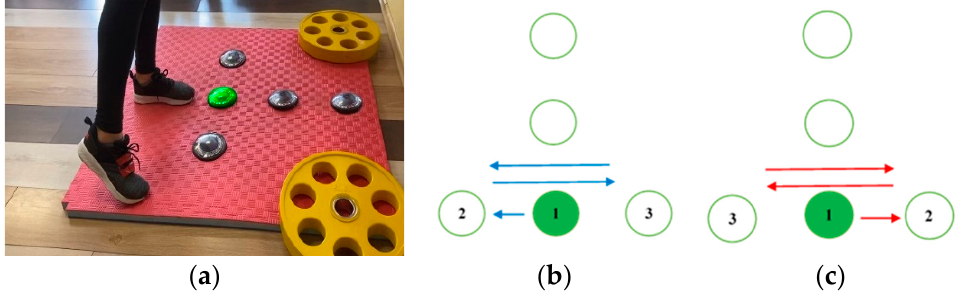
Figure 3. Test 2 (motion in the medio-lateral direction): ( a ) starting position for the right leg execution; ( b ) movement pattern of the active right leg; ( c ) movement pattern of the active left leg. The tests performed with the right and the left leg are denoted with Test 2R and Test 2L,